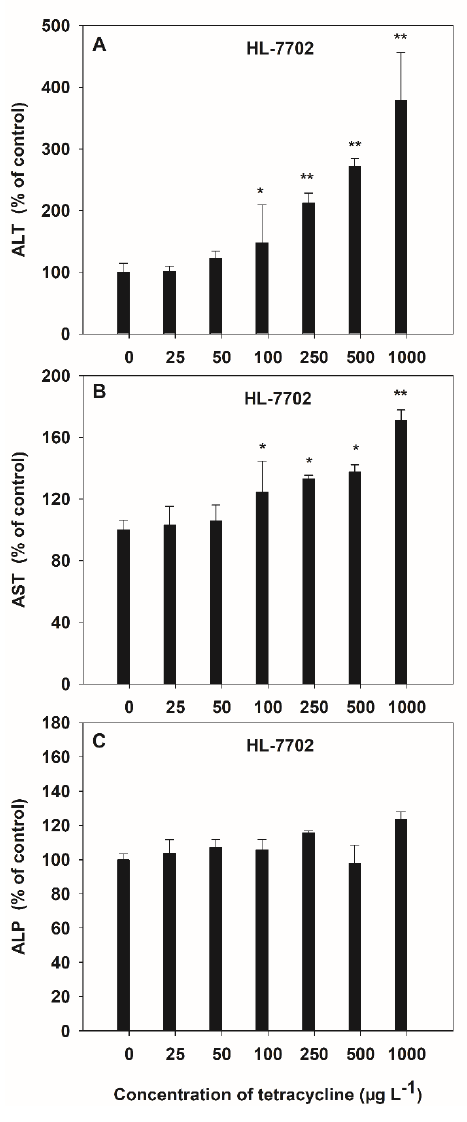
Figure 3. Effects of TC on the activities of ALT ( A ), AST ( B ) and ALP ( C ) in HL-7702 cells after 4-h incubation. Results are expressed as mean ± S.E. ( n = 3); “*” and “**” indicate significant ( p < 0.05) and highly significant ( p < 0.01) differences between controls and treatments,